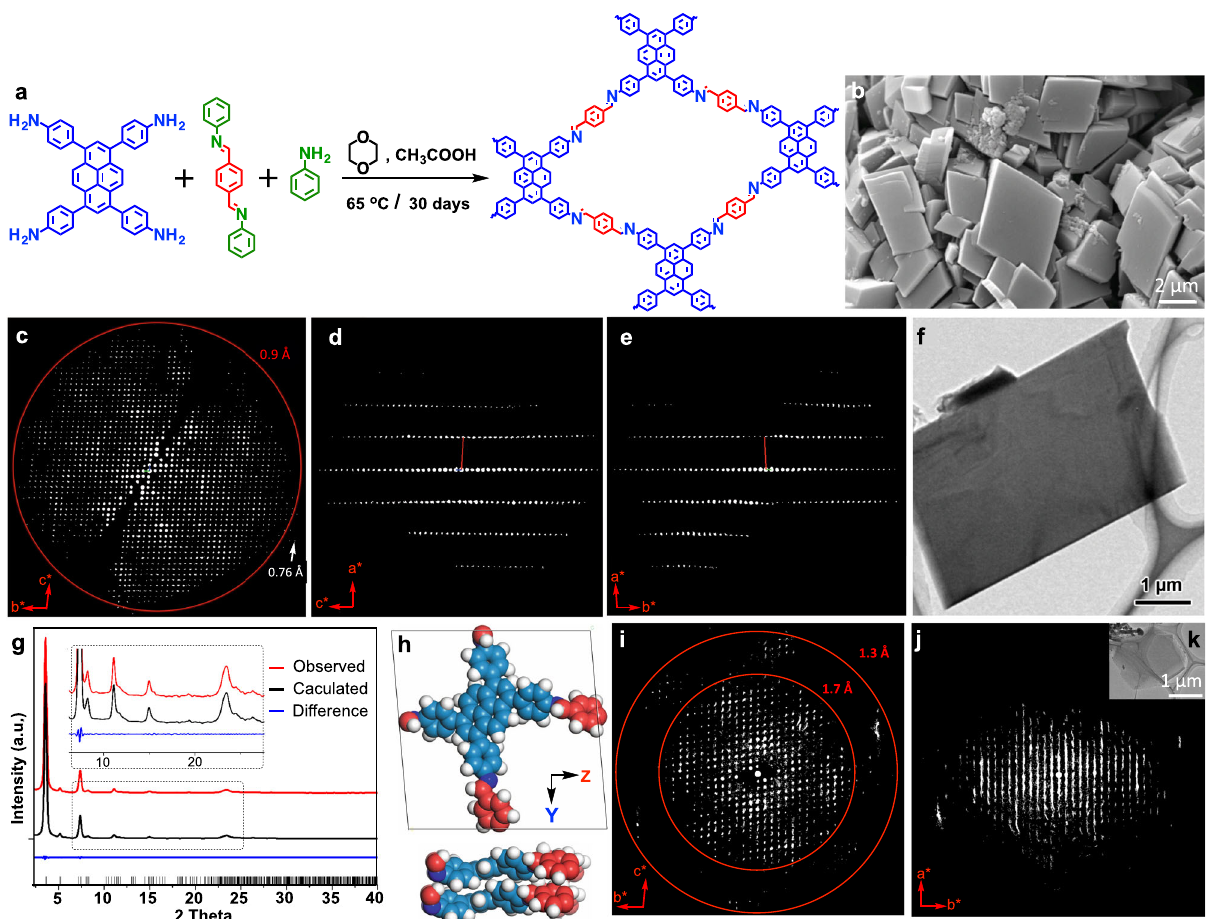
Fig. 4 Growth of 2D COF Py-1P single crystals. a Chemical structure of Py-1P COF and synthesis from DTA (blue) and PPA (red/green). b SEM image of Py-1P crystals. c – e 3D reciprocal lattice of Py-1P reconstructed from the cRED data viewing along the ( c ) [100], ( d ) [010], and ( e ) [001] directions. f TEM image of the Py-1P crystal used for cRED data collection. g Pawley fi tting of powder X-ray diffraction ( λ = 1.54178 Å) for Py-1P. Red line: observed; black line: calculated; blue line: difference; black bars: Bragg conditions. h Single crystal structure of Py-1P COF. A reconstructed 3D reciprocal lattice of the Py-1P- 6 structure viewing along the ( i ) [100] and ( j ) [001] directions. k TEM image of the Py-1P-6